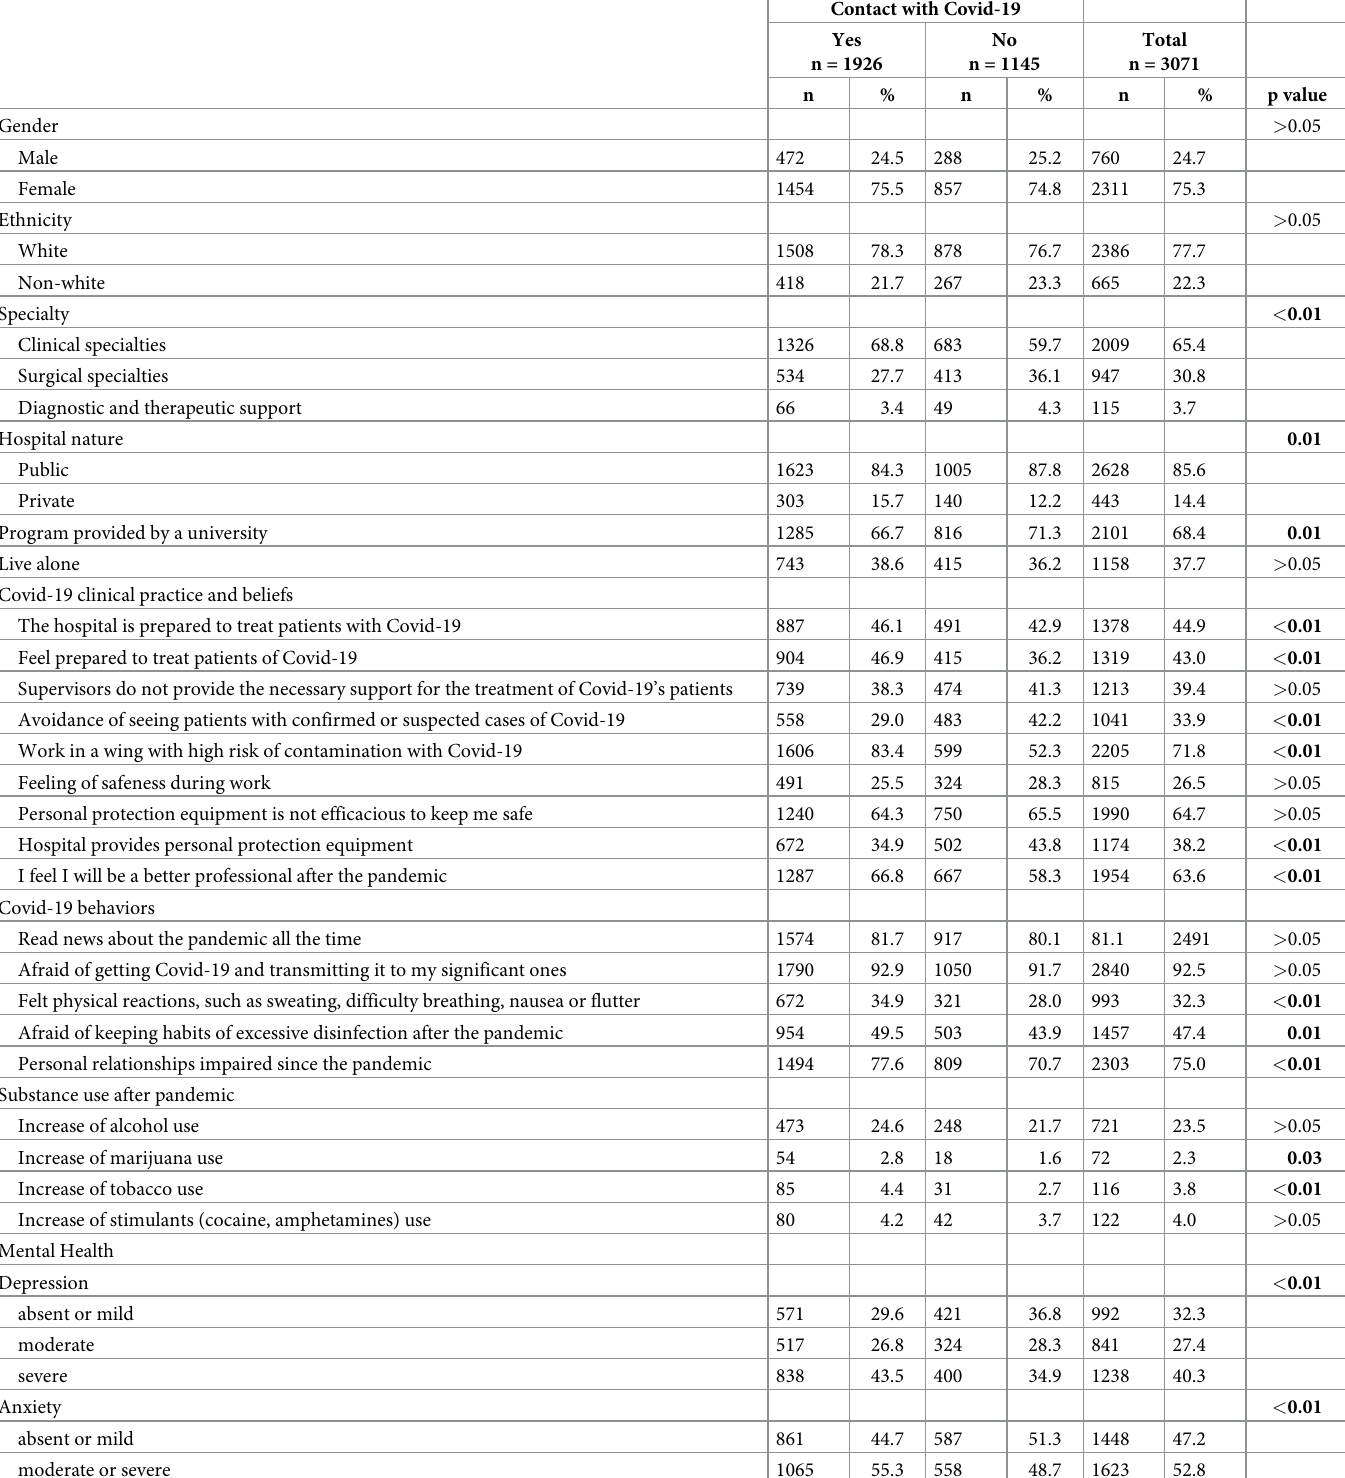
Table 1. Descriptive statistics of 3071 residents from Brazil,